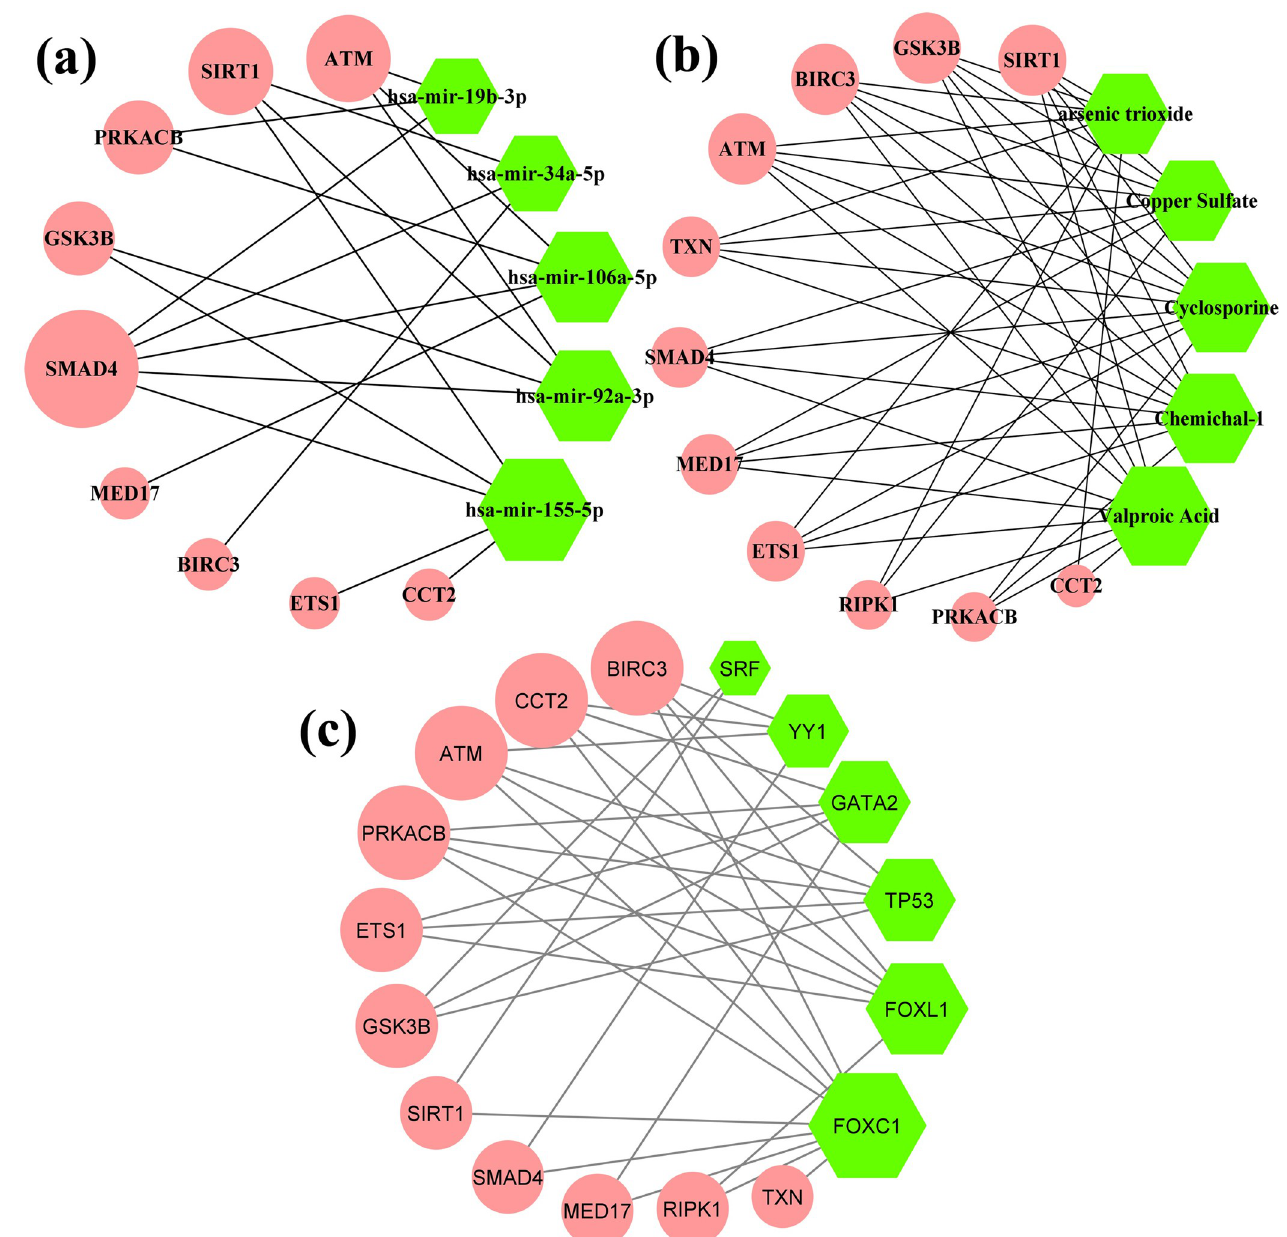
Fig 4. (a) miRNAs-HubGs interaction network based on TarBase and miRTarBase databases (b) Chemicals-HubGs interaction network based on comparative toxicogenomics database; where, Chemichal-1: (6-(4-(2-piperidin-1-ylethoxy)phenyl))-3-pyridin-4-ylpyrazolo(1,5-a)pyrimidine. (c) TFs-HubGs interaction network based on JASPAR